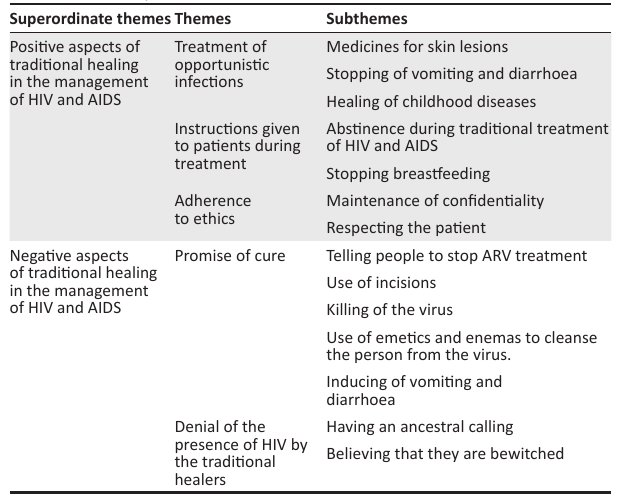
TABLE 1: Summary of the